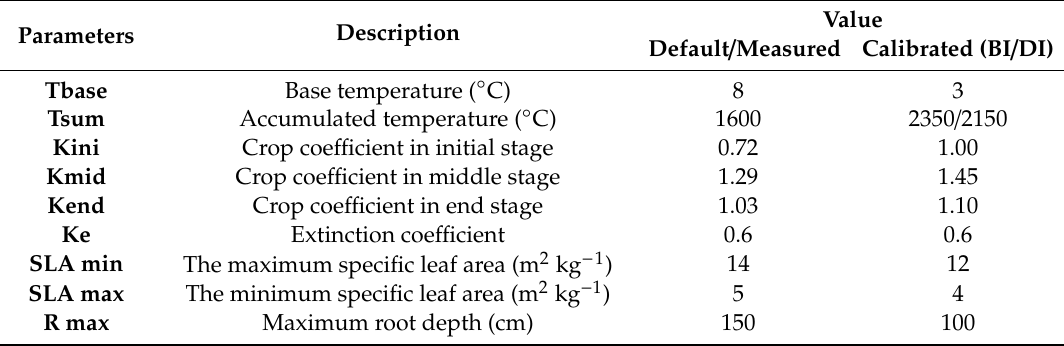
Table 5. Crop parameters used in water, heat, carbon and nitrogen simulator (WHCNS)